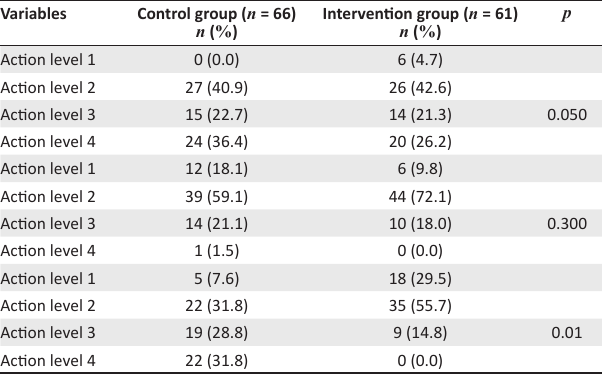
TABLE 3: A comparison of the number of participants in rapid upper limb assessment action levels between the control and intervention groups at baseline, 3 months and 6 months ( n = 127).